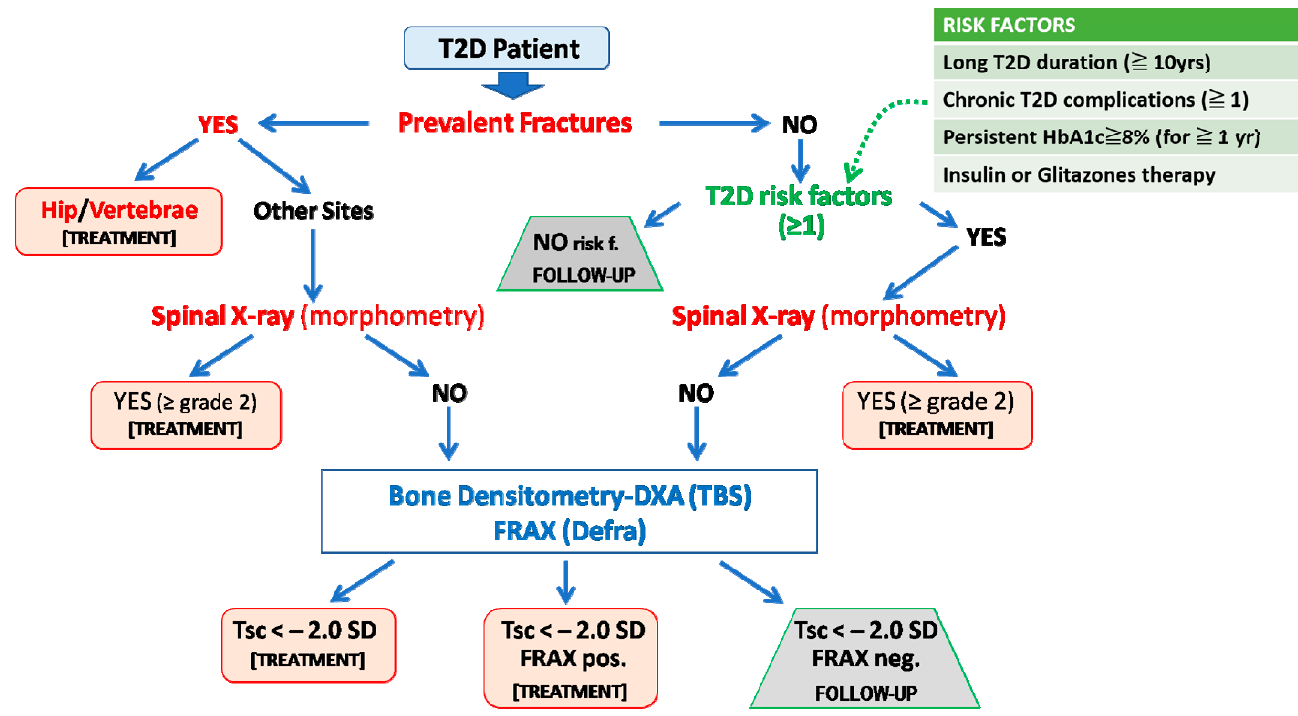
Figure 3. Algorithm for fracture risk stratification in type 2 diabetes. The prediction of fracture risk in patients with type 2 diabetes (T2D) should first rely on the presence of fragility fractures (including the identification of morphometric vertebral fractures) or, in their absence, on T2D-specific risk factors (e.g., duration of disease, glycemic control, ongoing treatments with insulin or thiazolidinediones, and the presence of typical T2D complications). Then either BMD or FRAX assessment could be used as an additional informative tool. We suggest that FRAX should be country-adapted and calculated without bone mineral density and with rheumatoid arthritis as a surrogate risk factor of diabetes (FRAXpos = patients who fulfill the National Osteoporosis Foundation criteria for treatment: 20% ten-year risk of major fragility fractures and 3% ten-year risk of hip fracture). Adapted from Reference [2].